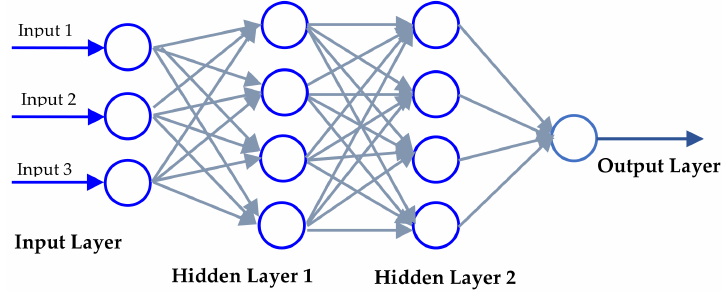
Figure 2. Artificial neural network [52].